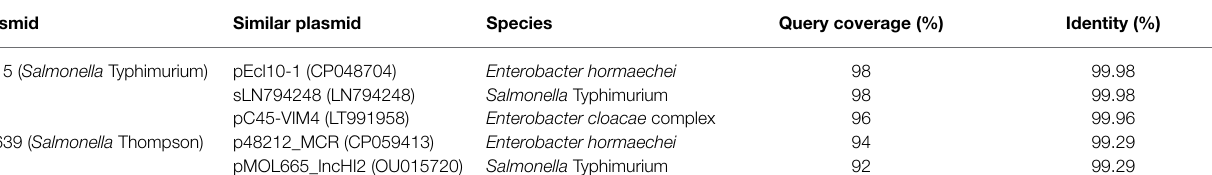
TABLE 4 | Comparison of two mcr-9- positive plasmids with similar plasmids.